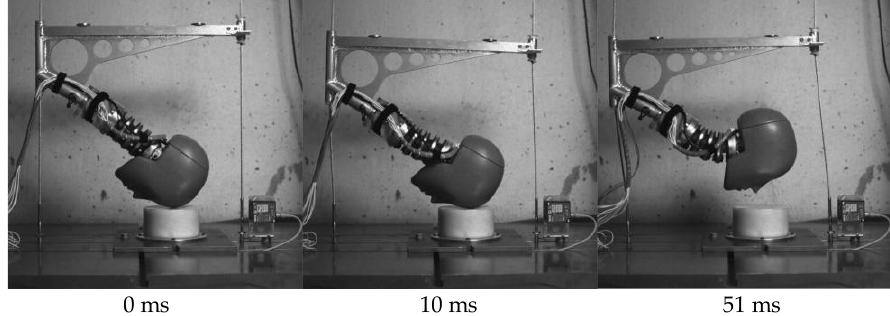
Figure 3. Estimated initial contact ( left ), end of contact ( middle ) and maximal neck extension ( right ) for drop